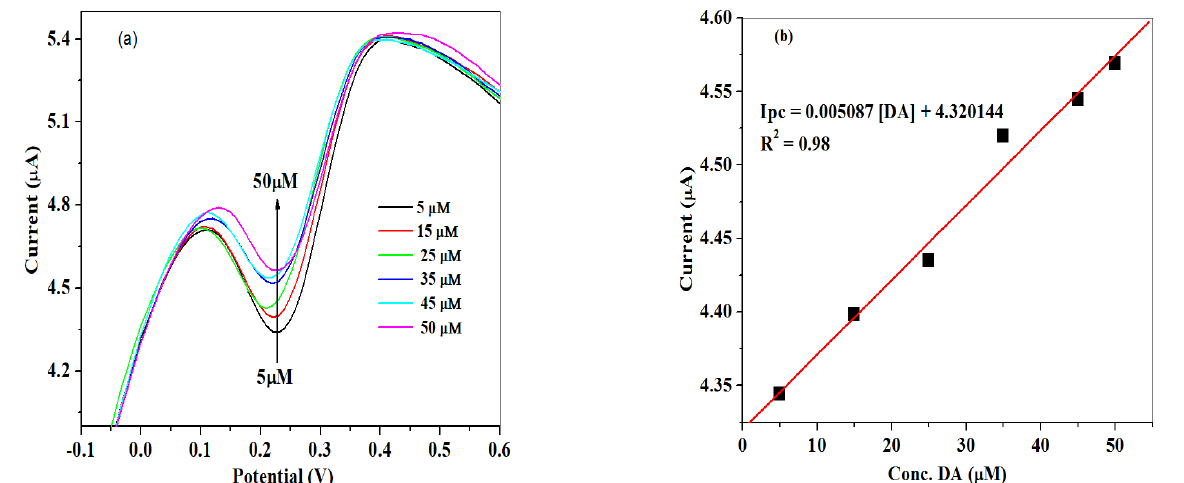
prepared in 0.1 M PBS (pH 7.4).